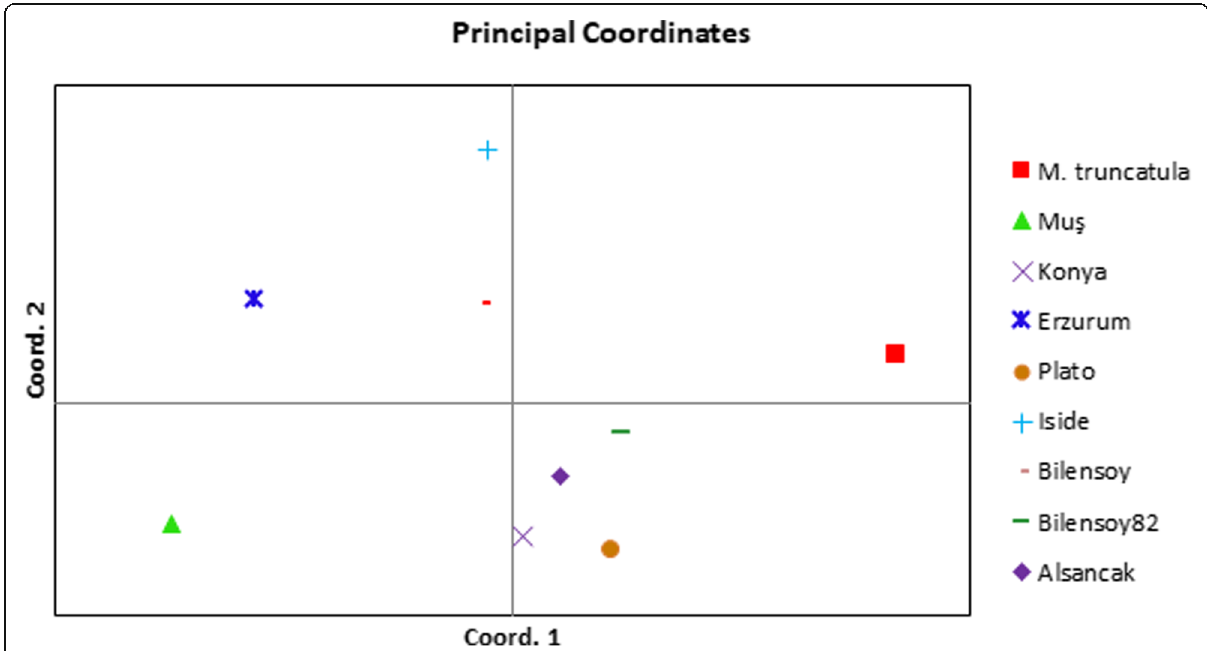
Fig. 5 The first two PC plots clarified 53% of total genetic variance with PC1 = 28% and PC2 =